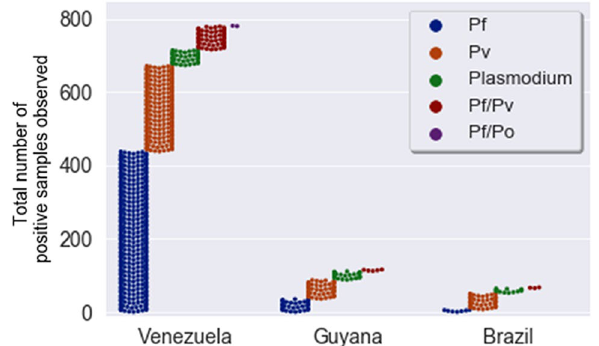
Figure 3. Number of malaria positives samples stratified by Plasmodium species and the probable country of origin of infection. The total number of malaria isolates observed in the three main countries of probable origin of infection (Venezuela, Guyana and Brazil) is shown. The different colors represent different species with each dot representing a sample. A total of 82 samples tested positive for Plasmodium, but the species could not be identified. Pf = P. falciparum , Pv = P. vivax , Po = P. ovale. Figure does not include 3 samples from Suriname (1 (Pf; 1Pv; and 1Pf/Pv) and 2 from French Guiana (Pf).